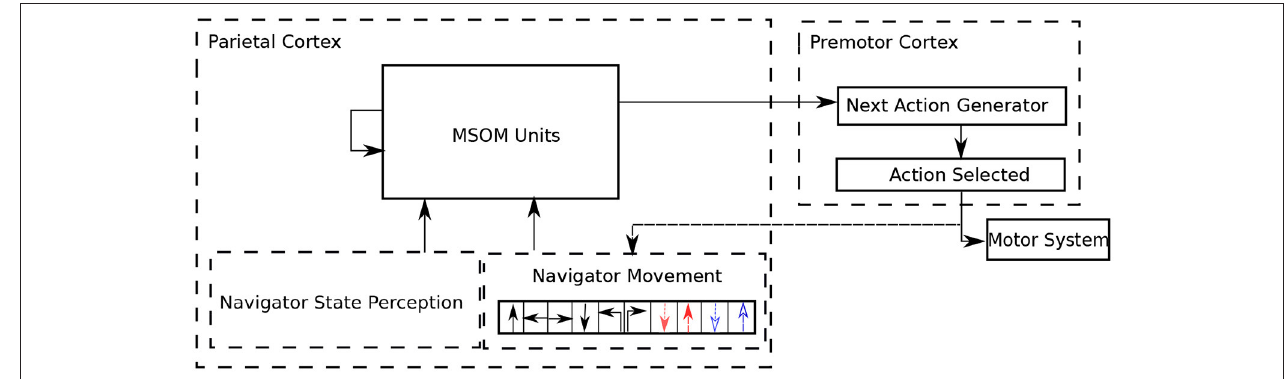
: translating forward; : ↑ ←